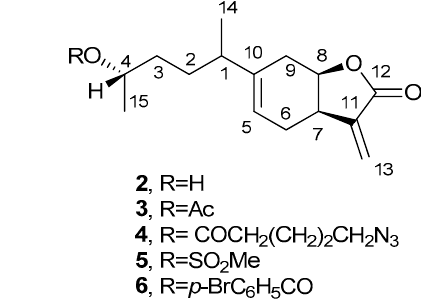
Figure 1. The structures of inuloxin E ( 1 ), inuloxin D ( 2 ), and inuloxin D derivatives ( 3 – 6 ).